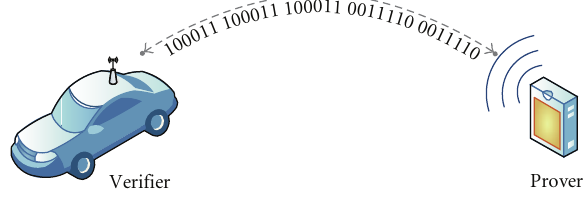
Figure 1: Access control: authentication